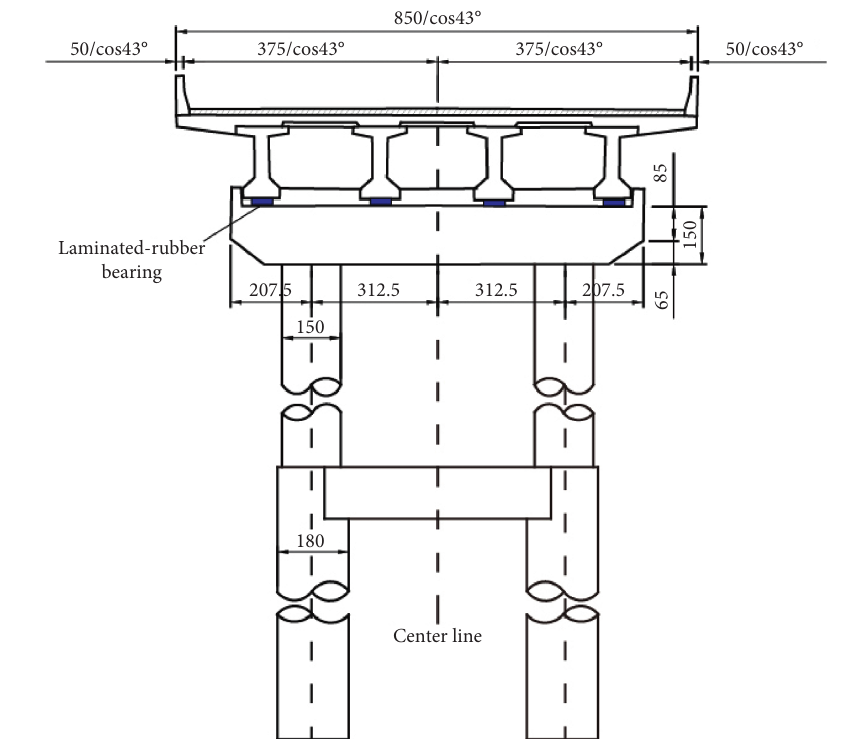
Figure 3: Typical bent section (unit: